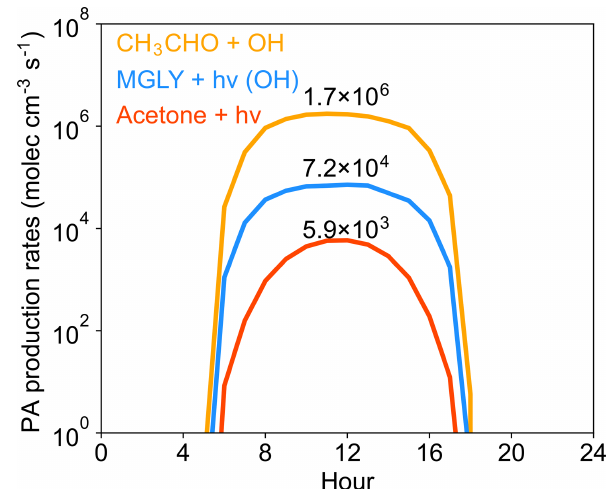
Figure 7. Estimated variations in daytime PA production rates (molecules per cubic centimeter per second; hereafter molec.cm − 3 s − 1 ) through CH 3 CHO, acetone, and MGLY, aver- aged during the observation period at the SDZ site. The numbers on the top of the lines denote the maximum values at noon through the three